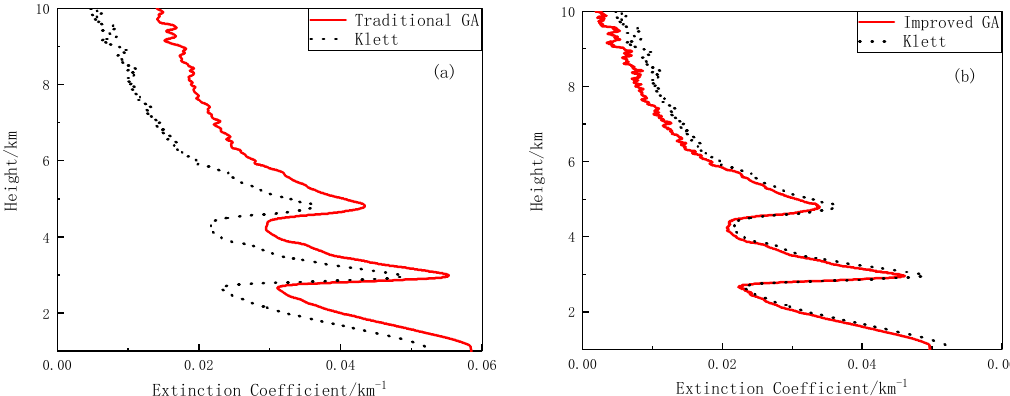
Figure 9. Inversion results obtained with two layers of cloud: ( a ) using the simple genetic algorithm and the Klett method, and ( b ) using the improved genetic algorithm and the Klett method.